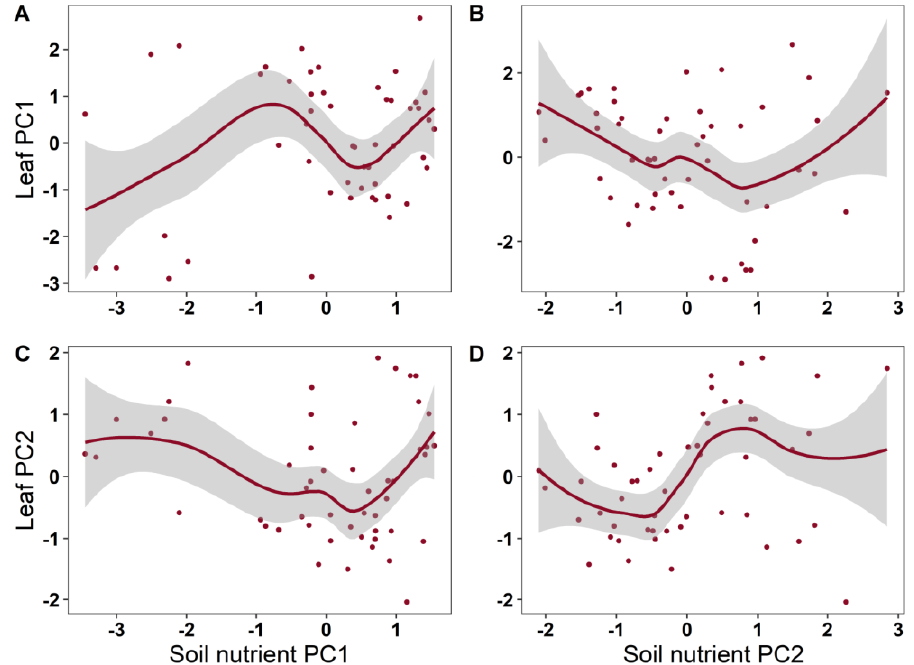
Figure 4. The plots of the GAMs smooth function indicating the effects of soil nutrient factors on leaf nutrient traits. A : soil nutrient PC1 vs. leaf PC1; B : soil nutrient PC2 vs. leaf PC1; C : soil nutrient PC1 vs. leaf PC2; D : soil nutrient PC2 vs. leaf PC2.